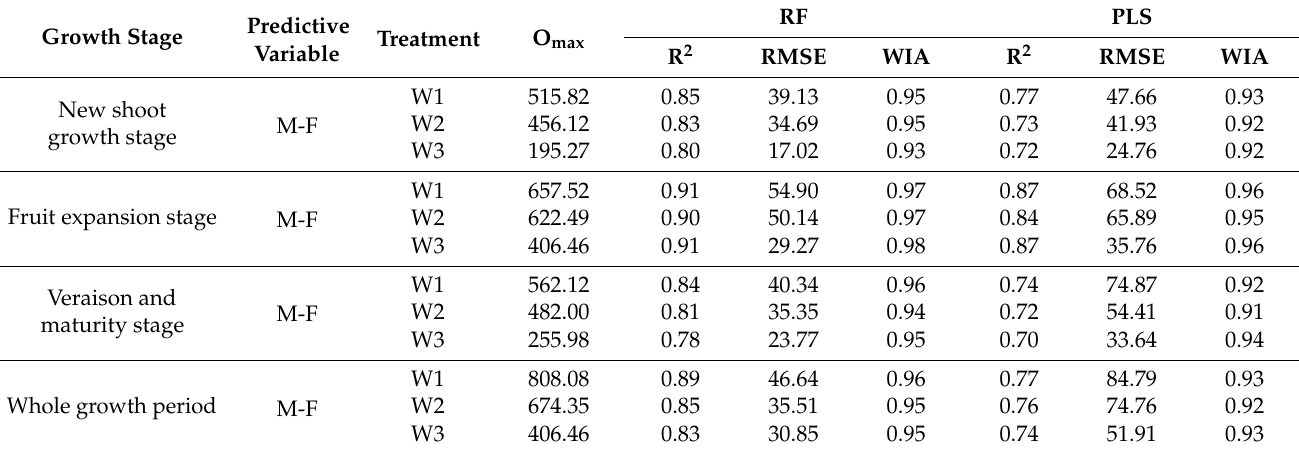
Table 3. Analysis of prediction results of different grape sap flow rate models by